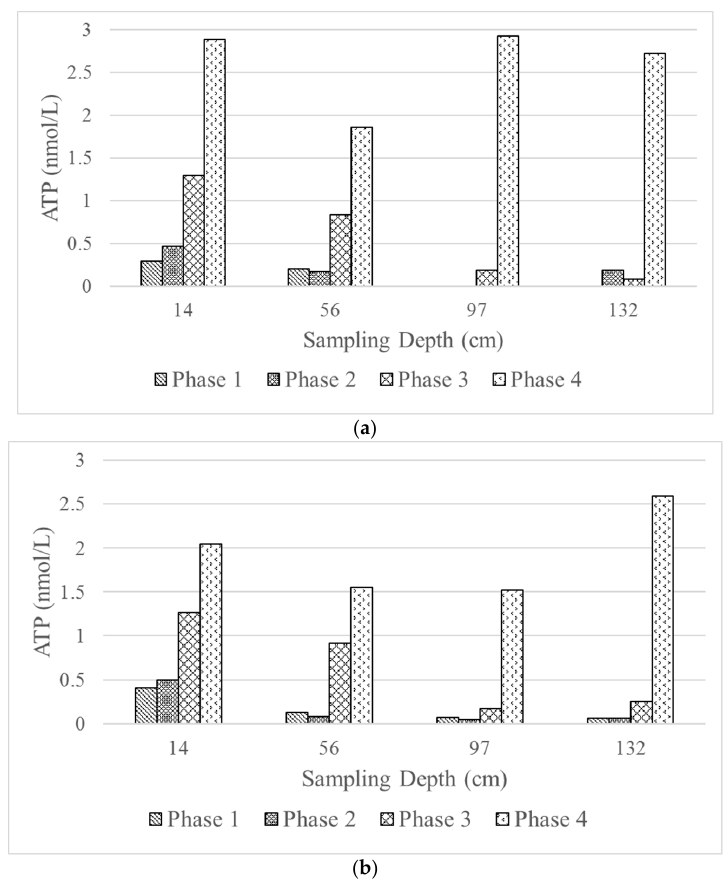
Figure 6. Biological activity represented by adenosine tri-phosphate (ATP) levels in ( a ) Column 1 and ( b ) Column 2 at different filter depths and phases of the experiment.